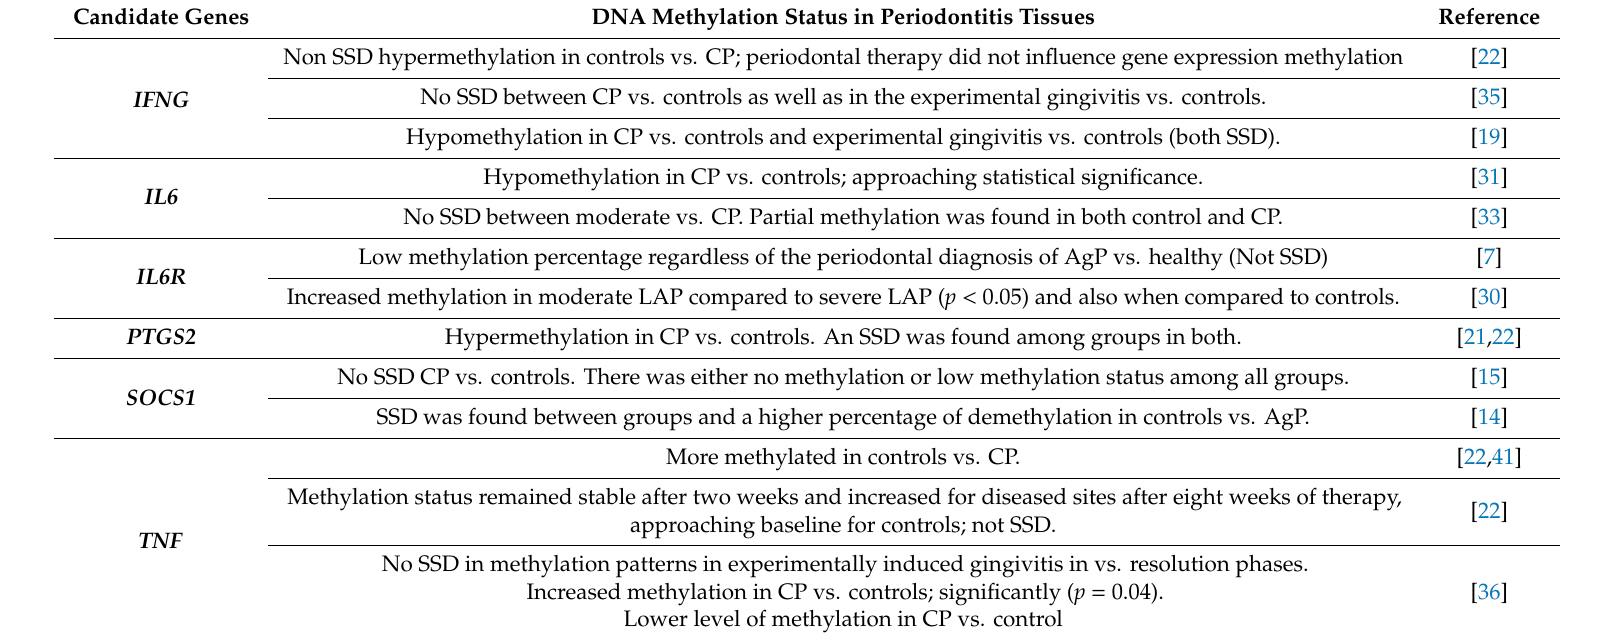
Table 3. Summary of the candidate genes that have been assessed for DNA methylation in